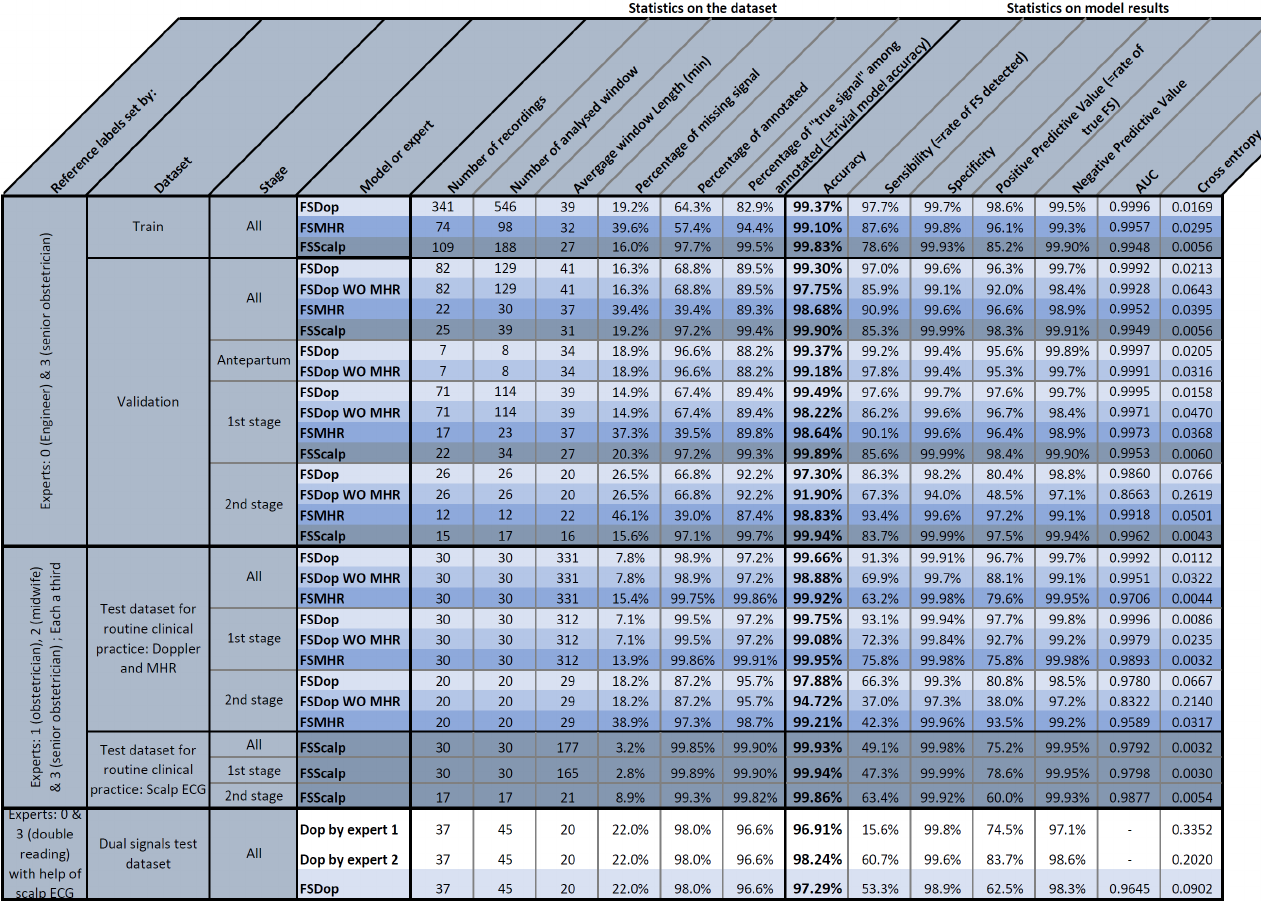
Figure 8. Statistical results for the study’s models and